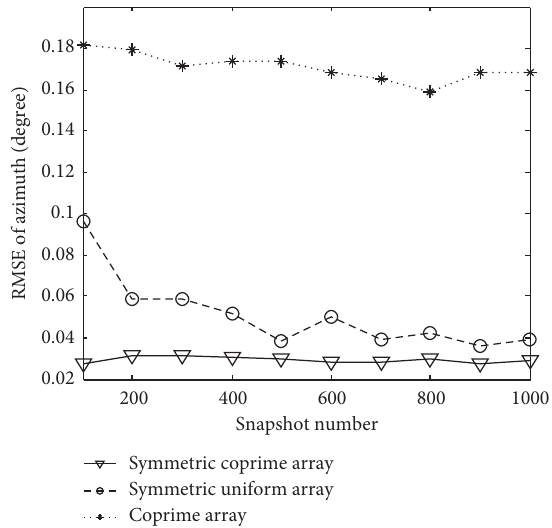
Figure 11: The RMSE of azimuth versus snapshot